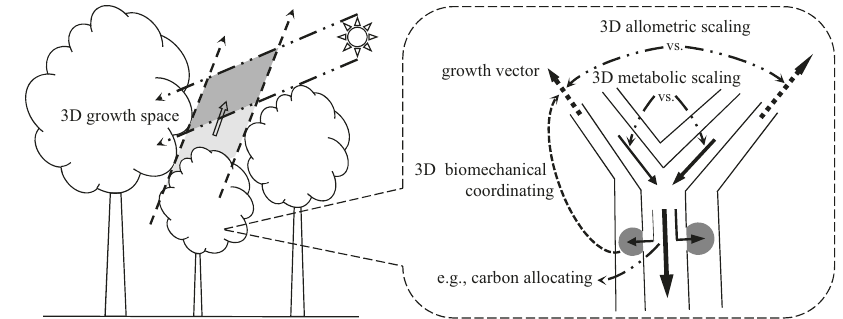
Fig. 3 The principle feasibility of going towards 3D basic theories of plant forms. Illustration of the principle framework for supportively advancing 3D basic theories of plant forms, after fi nding their laws with deviations (Fig. 1) and proposing vector parameters for characterizing the form-related functional traits and their driving forces (Fig. 2). In terms of carbon that is the basic element of composing plant forms and the coherent inner scaling relationships between their allometric, metabolic, and biomechanical aspects 66 , exploring 3D growth space leads to branches growing in the form of vector, branches growing in the form of vector means 3D allometric scaling, 3D allometric scaling brings about 3D metabolic scaling, 3D metabolic scaling causes asymmetrical carbon allocating, asymmetrical carbon allocating gives rise to 3D biomechanical coordinating, and in the end back to where this cycle starts, 3D biomechanical coordinating alters growth vectors. Under this framework ranging from physical demand (left) to mechanism foundation (right), new 3D basic theories of plant forms can be comprehensively and systematically explored